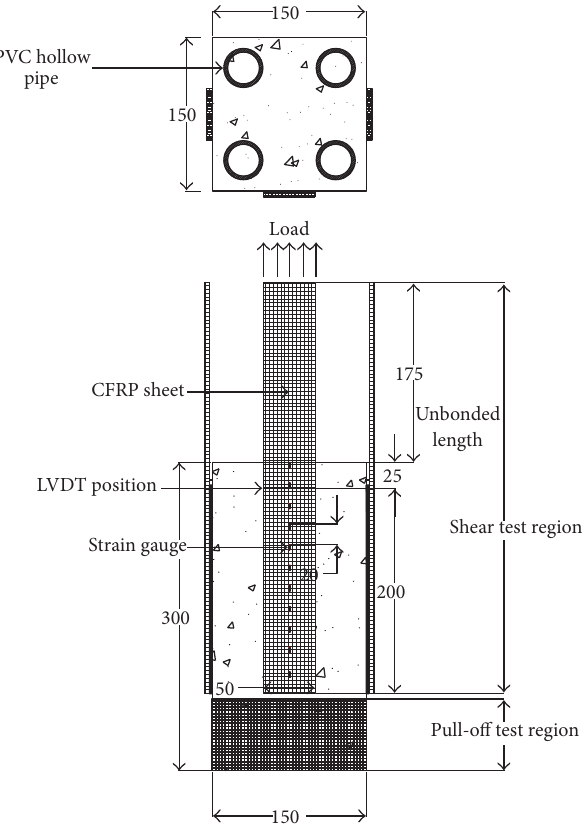
Figure 1: Details of bond specimen (unit: mm) for single lap shear